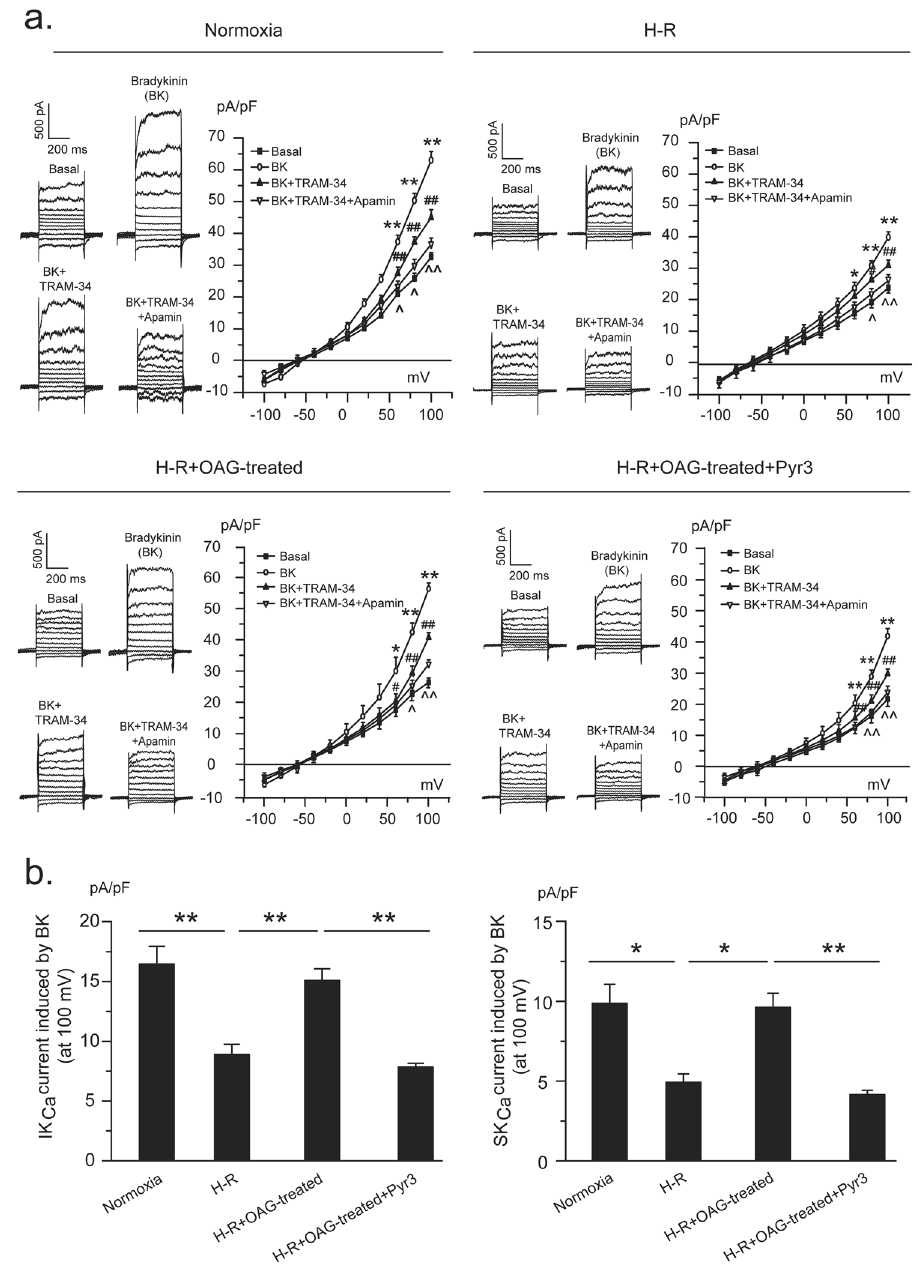
Figure 4. Activation of TRPC3 channels protects IK Ca and SK Ca channels from H-R-induced inhibition in PCAECs. ( a ) Representative traces and current-voltage relationship of whole-cell K + current in PCAECs from different treatment groups before and after bradykinin (BK) stimulation with further application of the IK Ca channel blocker TRAM-34 and the SK Ca channel blocker apamin. Under H-R condition, PCAECs treated with OAG shows enhanced basal and BK-induced K + currents compared with the cells without OAG-treatment and such enhancement is diminished by Pyr3. * p < 0.05, ** p < 0.01, BK vs. basal; # p < 0.05, ## p < 0.01, BK + TRAM-34 vs. BK; ^ p < 0.05, ^^ p < 0.01, BK + TRAM-34 + Apamin vs. BK + TRAM-34. ( b ) Summarized data of BK-induced IK Ca and SK Ca currents from 5 independent experiments, each obtained from cell isolates of different hearts. PCAECs were subjected to H-R exposure in the absence or presence of the TRPC3/6/7 activator OAG before patch-clamp recording. For cells subjected to H-R exposure and OAG treatment, the current recording was performed under the condition without (H-R + OAG-treated) or with Pyr3 application (H-R + OAG-treated + Pyr3). * p < 0.05, ** p < 0.01; one-way ANOVA and Scheffe post-hoc